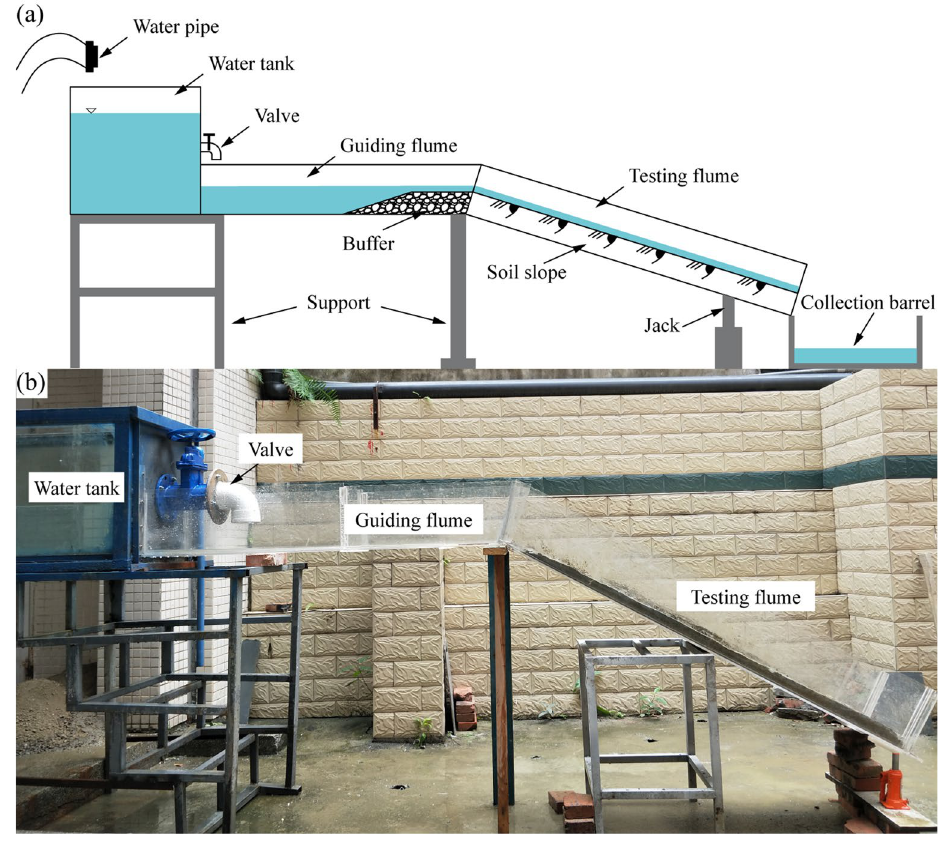
Figure 3. Diagram of the scouring experimental